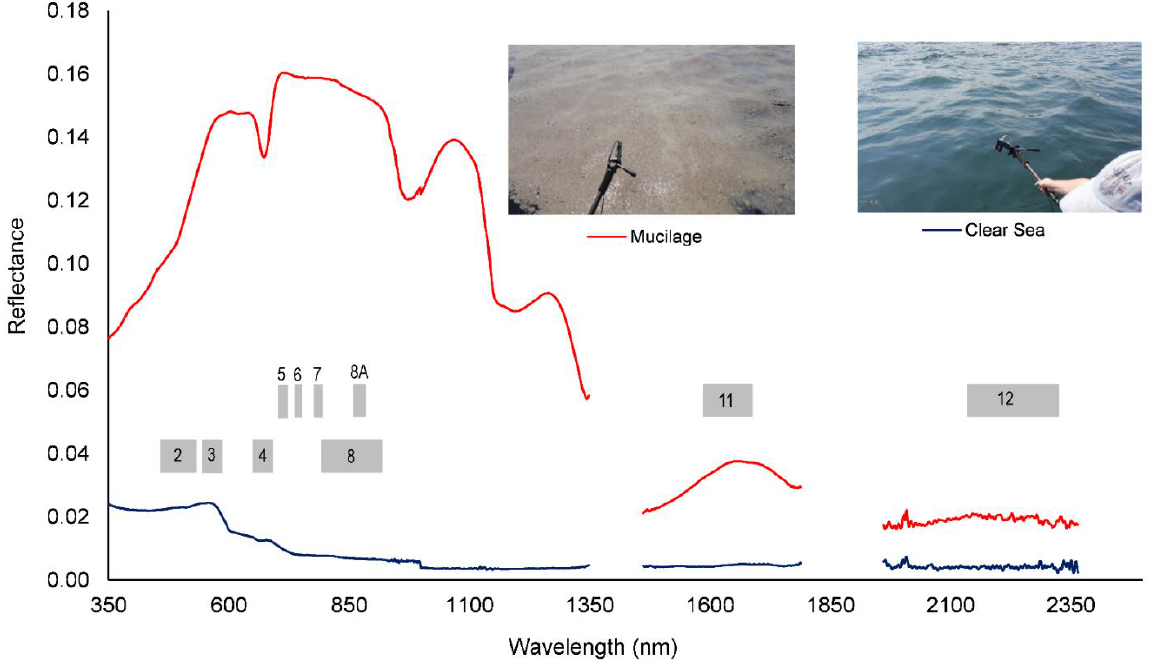
Figure 1. The spectral signature of clear water and floating mucilage. Note that 2,3…, 12 represent the locations of the Sentinel-2 bands used in this study.